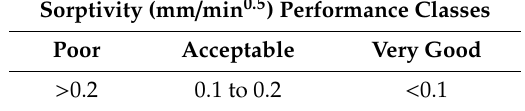
Table 2. Sorptivity performance classes proposed by Papworth and Grace.